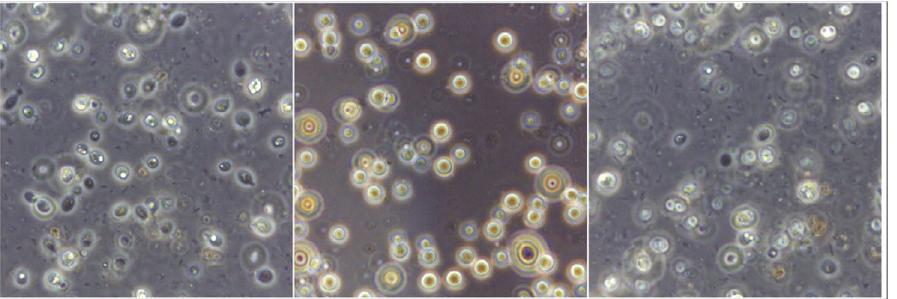
Fig. 5. Phase contrast microscopy of reference sample - Papiliotrema laurentii (MTCC 2898), under 100X